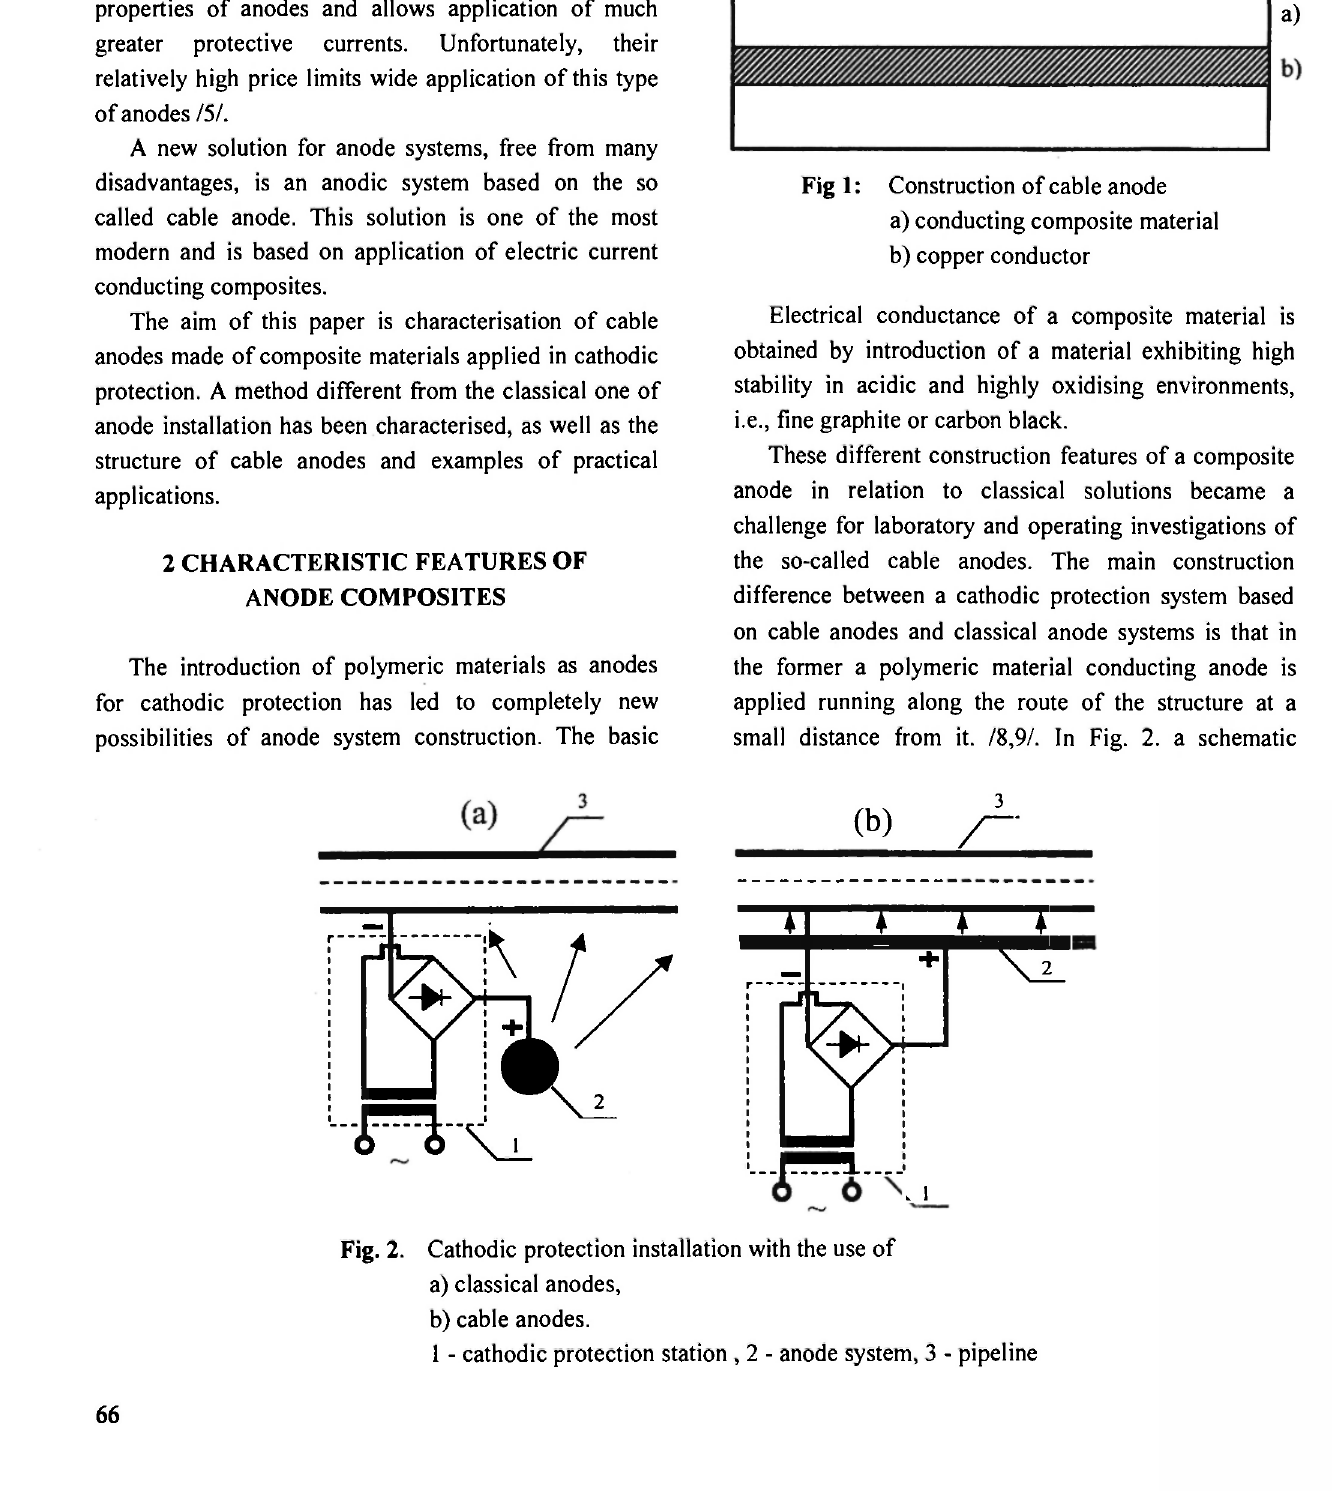
Construction of cable anode